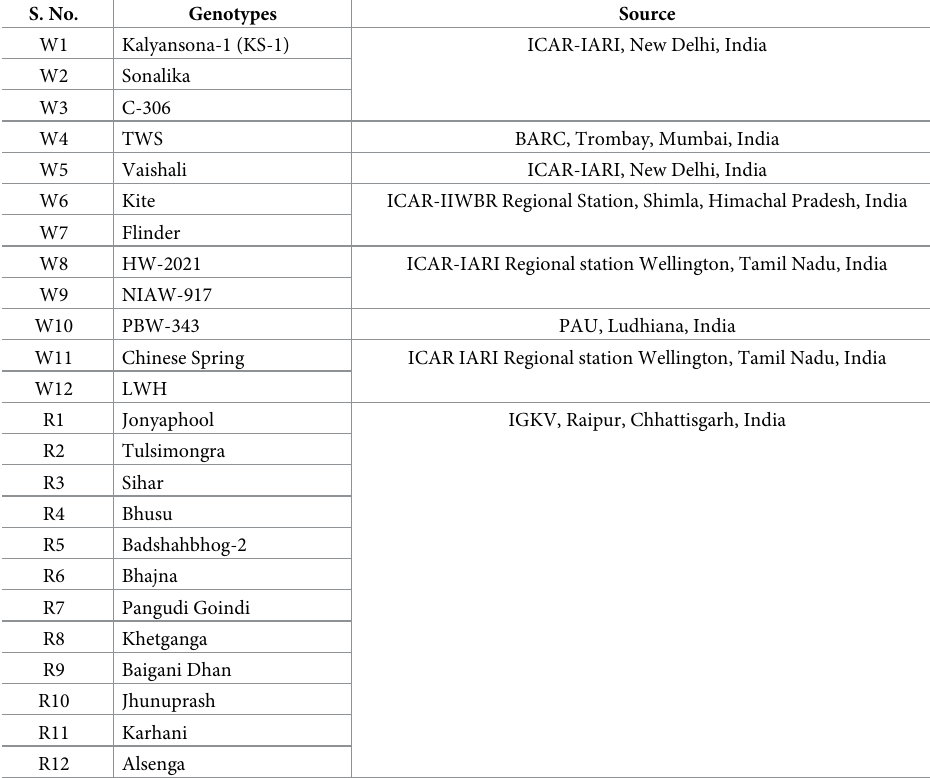
Table 1. List of wheat (W1 –W12) and rice (R1 –R21) genotypes used for analysis. S.